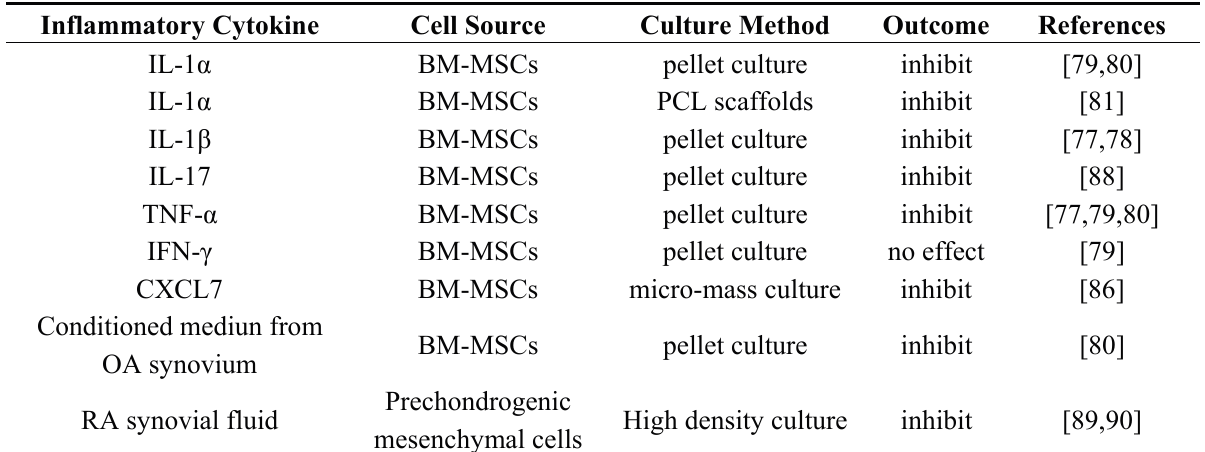
Table 1. Effect of cytokines on chondrogenic differentiation of human mesenchymal stem cells. Inflammatory